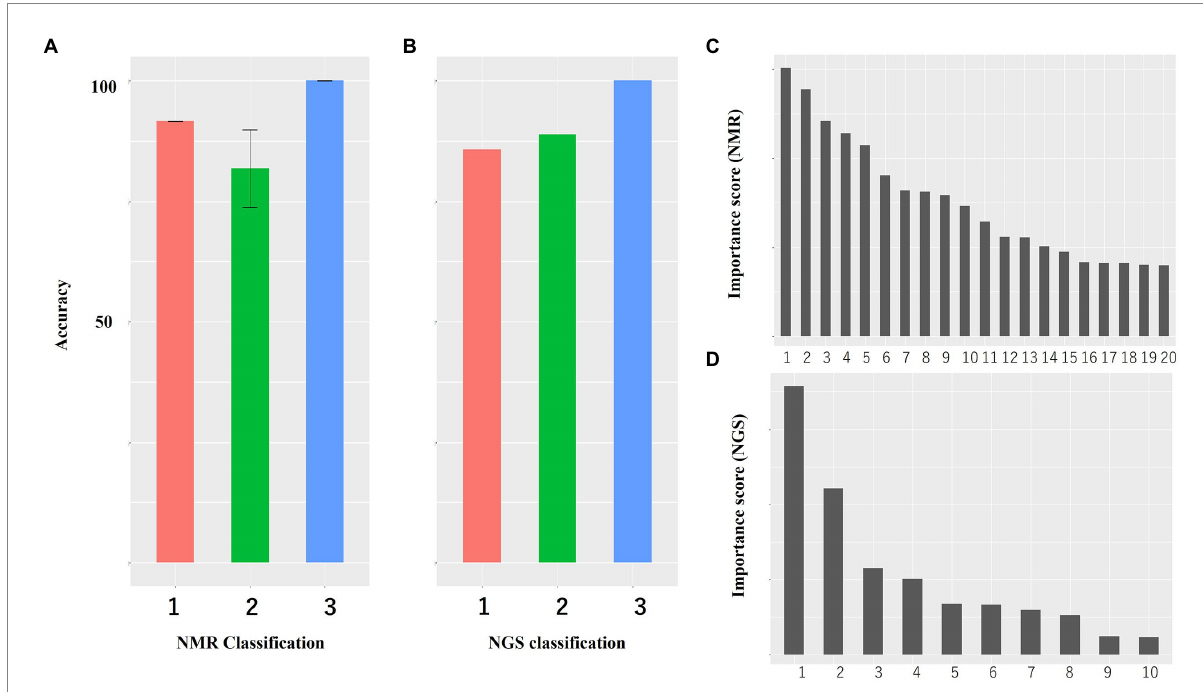
FIGURE 3 Accuracy of classification of NMR data and NGS data and histogram of importance computed using i-means. (A) Both NMR and (B) NGS data are highly accurate. The numerical value is the average value of five measurements. Bars indicate standard deviation, and no bars indicate no variation. (C,D) Histogram of important variables of NMR (C) and NGS (D) computed using i-means. Important factors were extracted. The importance scores are shown in Tables 2, 3. (A,B) The numbers indicate the number of classes divided using i-means. The rankings of panels C,D are shown in Tables 2, 3, respectively. There were originally four groups for NGS, but one group including one sample was omitted because it was microbiota composition